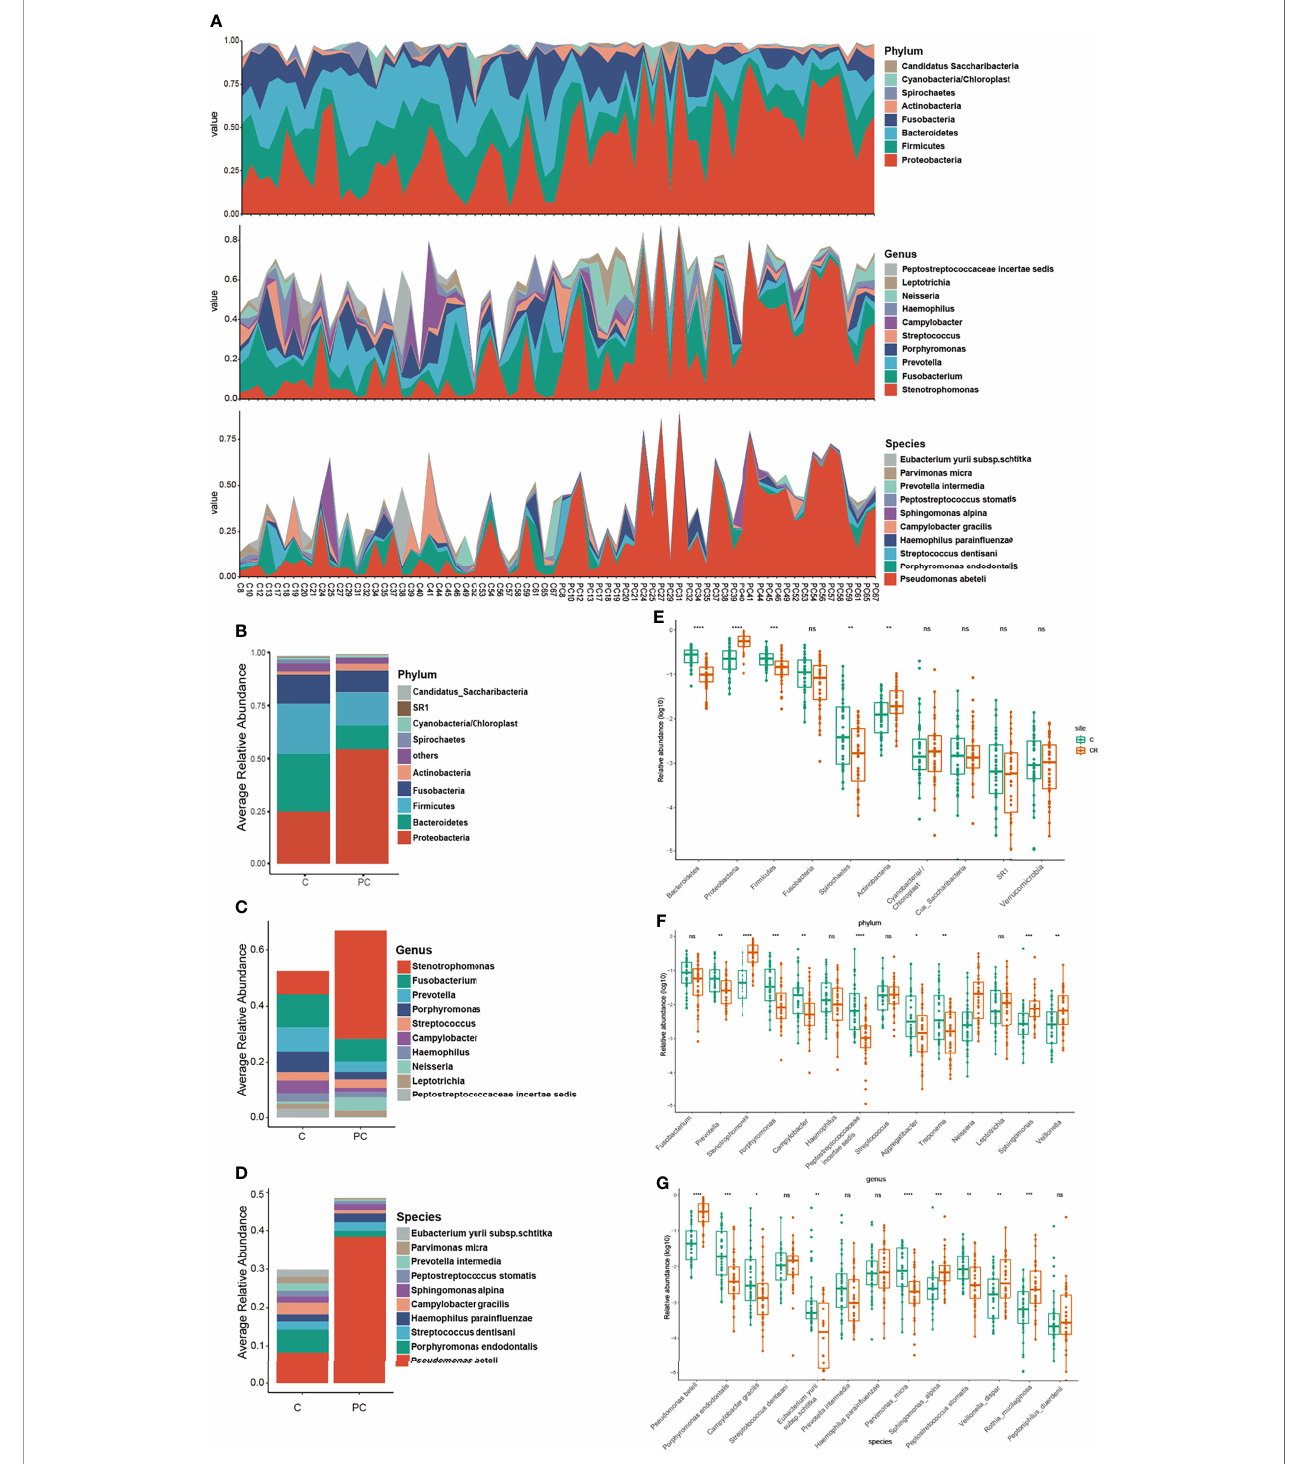
FIGURE 2 | (A) The comparison of taxonomic composition between tumor and paracancerous tissue samples. Distribution of relative abundance of microbiome in the tumor tissue and paracancerous tissue of each OSCC subject at the phylum, genus, and species level. Histograms described relative abundances of the (B) top 10 phylum, (C) 10 genera, and (D) top 10 species in the tumor tissue and paracancerous tissue. (E – G) Prevalence of bacterial phylum, genera and species associated with tumor and paracancerous tissue of OSCC subjects. C, tumor tissue; PC, paracancerous tissue. ns, no signi fi cance; * P< 0.05, ** P <0.005, *** P <0.001, **** P